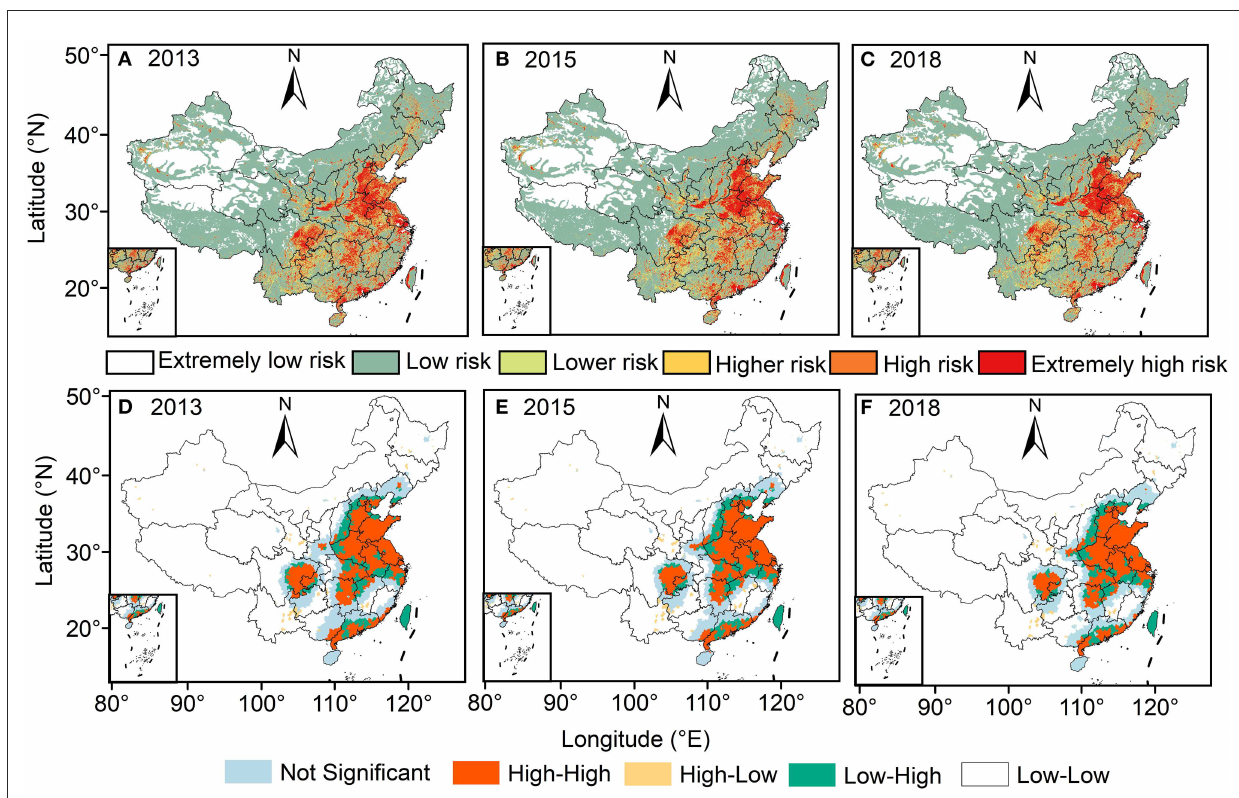
FIGURE7 Spatial distribution pattern of population exposure risk levels attributed to O 3 pollution from 2013 to 2018. (A–C) Indicates the spatial distribution of population exposure risk levels in 2013, 2015, and 2018, respectively; (D–F) Indicates the spatial clustering of population exposure risk levels in 2013, 2015, and 2018,